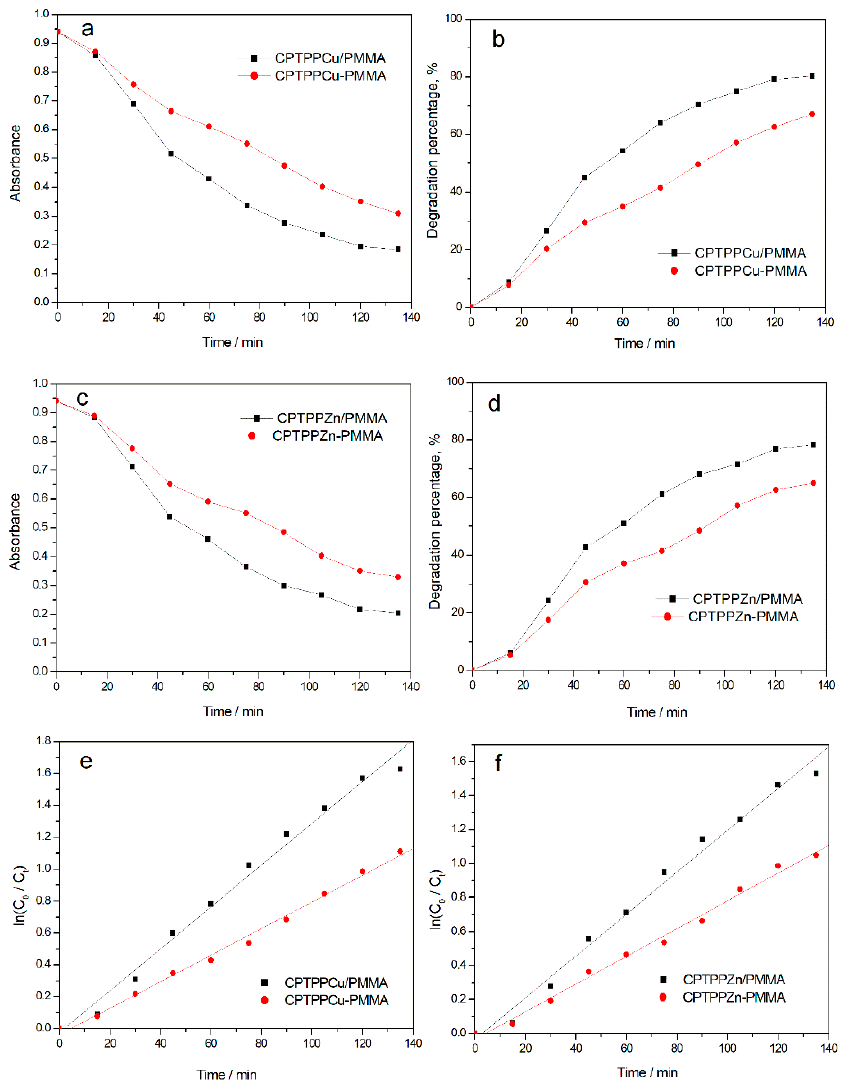
Figure 6. Absorbance curves ( a , c ) of MB solution catalyzed by different catalysts. Degradation percentage curves of MB catalyzed by different catalysts ( b , d ). Equation of first-order kinetic curve of catalytic degradation of MB with different catalysts ( e , f ).